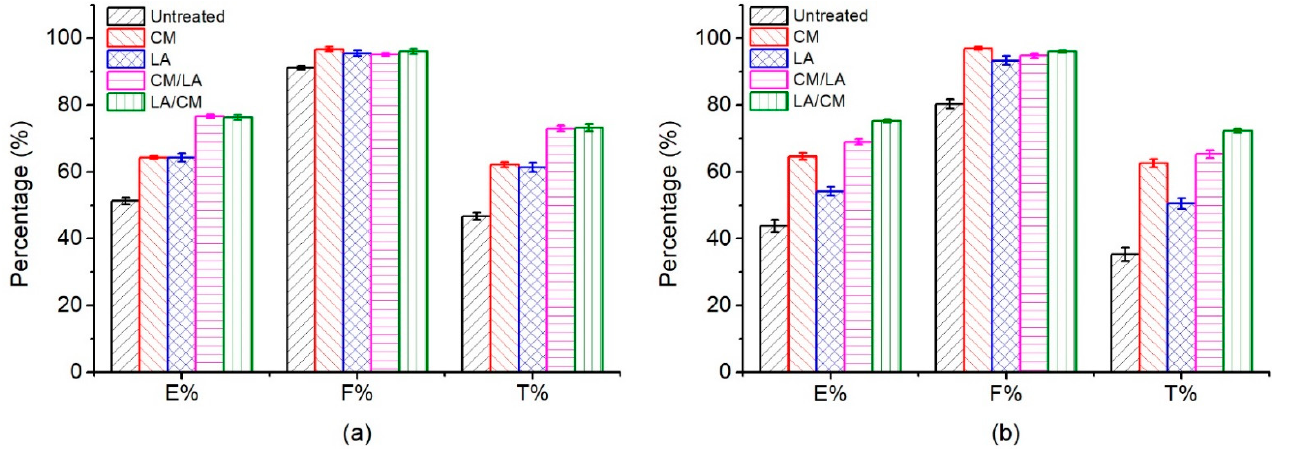
Figure 7. E%, F%, and T% of the dyeings of untreated and treated cotton fabrics using ( a ) Red 2 and ( b ) Red 195.